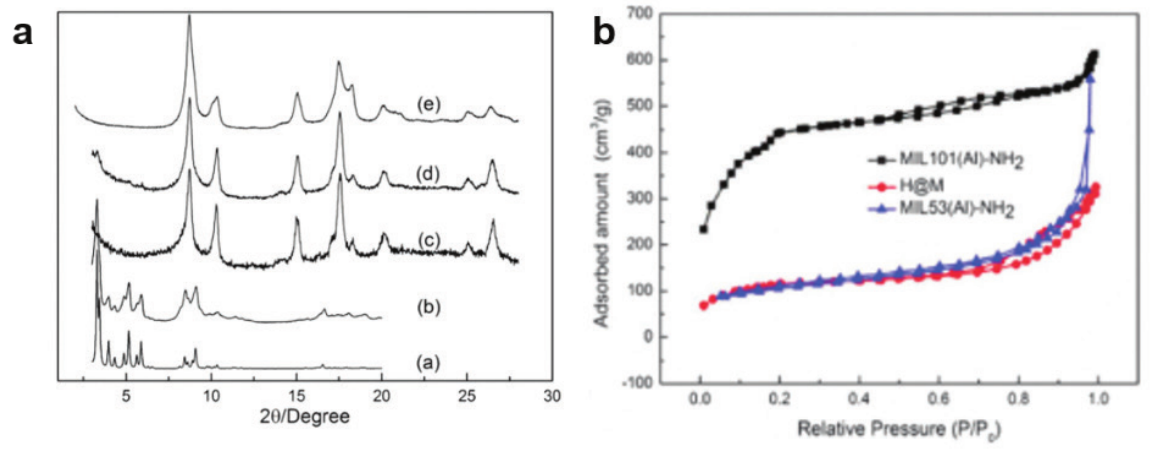
, (c) synthesised haemin@MOF, (d) MIL–101(Al)–NH soaked in 2 2 (black), haemin@MOF (red) 2